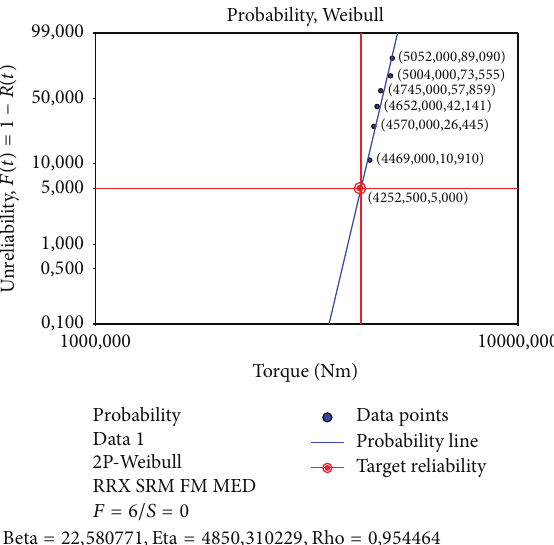
Figure 11: Weibull analysis of static torsion test results of welded joints.